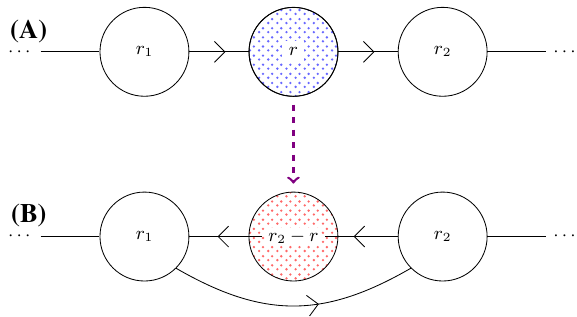
Fig. 5 2d Seiberg duality on a node with both fundamental and anti- fundamental matter with r 2 > r 1 . The rank of the dualized node is max ( r 1 , r 2 ) − r = r 2 − r . The blue and red colours indicate the node before and after the duality